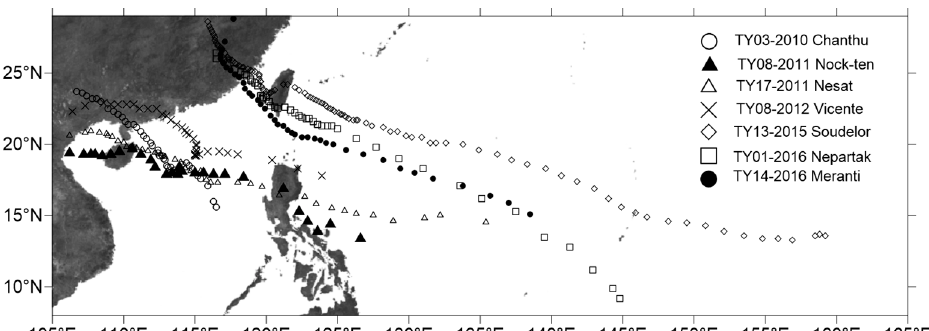
Figure 4. Tracks of seven representative typhoons in the Northwest Pacific.